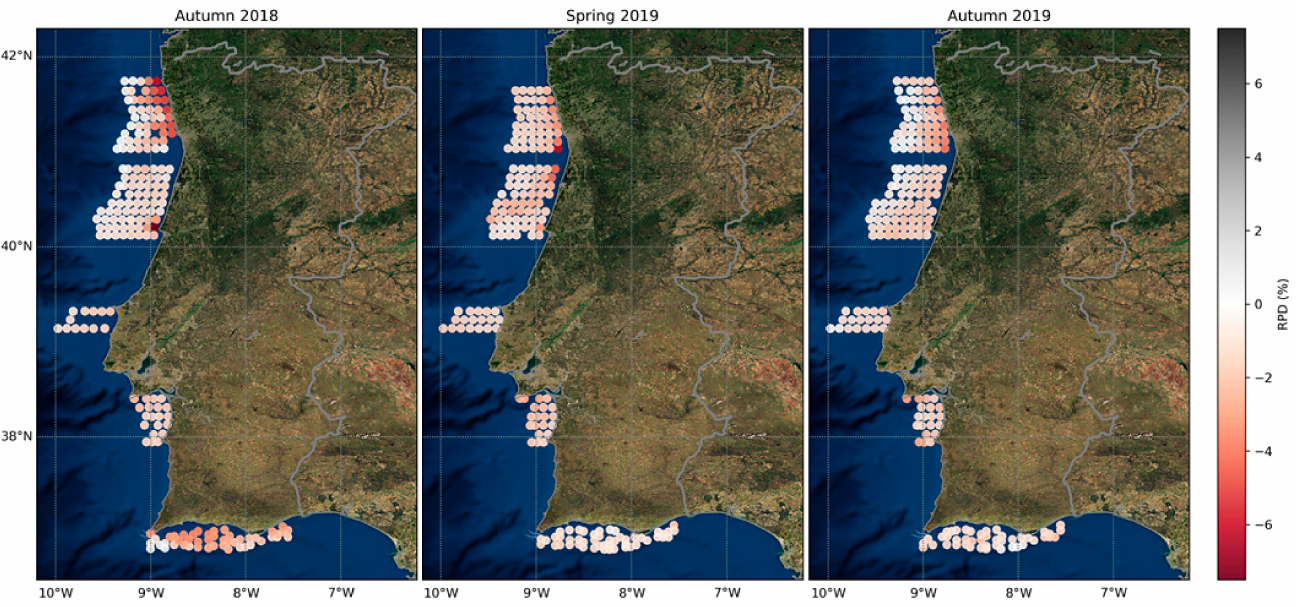
Figure 5. RPD (%) values of each satellite matchup along the Portuguese coast during the three cruises.